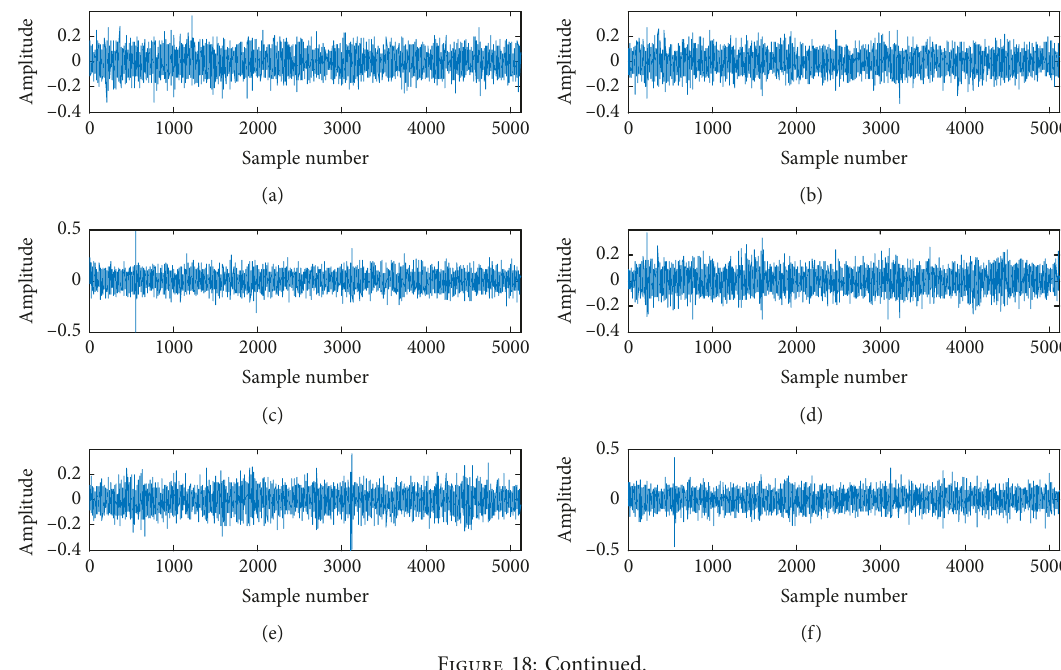
Figure 17: Multiresolution DMD modes of the normal roller bearing signal (NASA, snapshot 2003.10.31.08.59.46). Here, we select the first that represents the fourth layer slow or fast modes. (a)–(h) represent the modes of X column of X ij DMD , X , and X , respectively. The symbols in the Figures 18 and 19 share the same meaning. X 47DMD 48DMD 46DMD